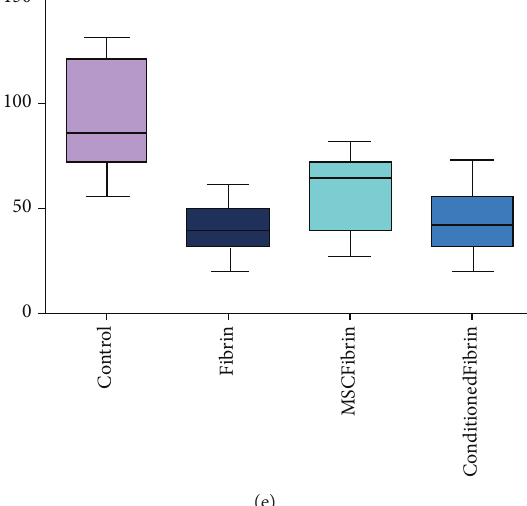
Figure 7: IHC sections of tibialis anterior (TA) muscles from the Control and treatment groups (after choosing fibrin glue—Tisseellyo as the preferred vehicle) with anti-human Pax7 antibody evaluated at d15 postmyectomy (magnification: 200x) (a–d). The Pax7 + labeling index was defined by the average number of Pax7 + positive nuclei which was determined by counting 5 selected fields at high power field magnification ( × 400) in each sample (e). Scale bar: 50 𝜇